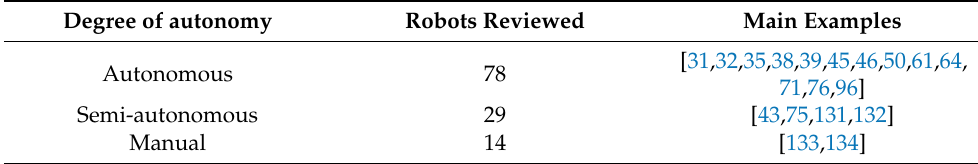
Table 5. Categorization of agricultural robots based on their degree of autonomy.